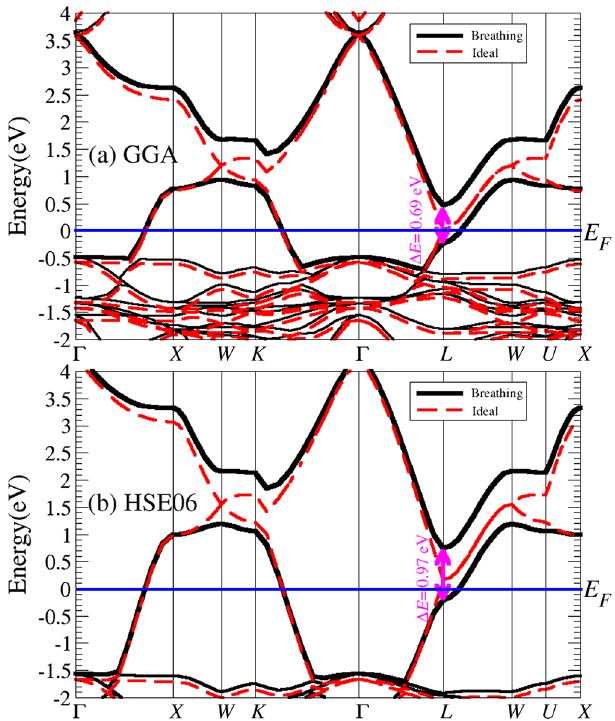
FIG. 4. Illustration of the big REPME of the oxygen-breathing O . The band structures of BaKBi O with mode at R in BaKBi 2 6 2 6 and without oxygen-breathing displacement are calculated by DFT using both the (a) GGA and (b) HSE06 hybrid functionals. We plot the band structure in the Brillouin zone of the fcc unit cell, corresponding to a 2 (cid:5) 2 (cid:5) 2 supercell of the simple cubic unit cell, where half of the Ba atoms are replaced by K atoms. The displacement of each oxygen is about 0.044 A˚ in the calculations. The band splittings that are indicated by the arrows are about 0.97 eV for the DFT HSE06 and 0.69 eV for the DFT GGA, resulting in REPMEs of about 11.0 and 7 : 8 eV = (cid:3)A , re- spectively. The corresponding scQP GW values are 1.21 eV and 13 : 7 eV = (cid:3)A , respectively. Note that the material remains metallic with the oxygen-breathing